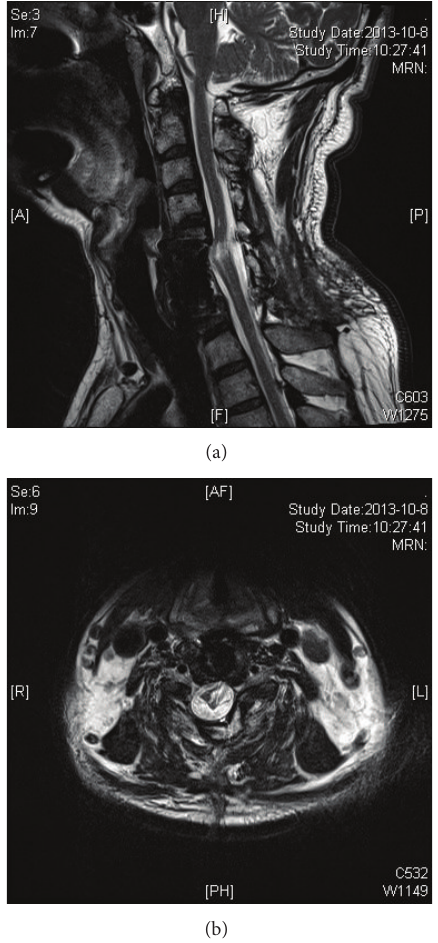
Figure 7: T2-weighted sagittal and axial magnetic resonance images made 3 months postoperatively. There is no stenosis, but persistent T2 high signal indicating myelomalacia is